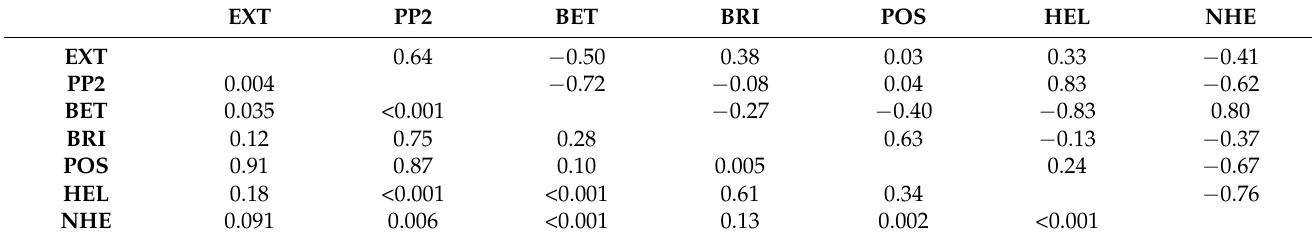
Table 2. Pair-wise comparison of the propensity scales for the ( ϕ , ψ ) clusters identified in the Ramachandran plot. The correlation coefficients R and the p -values are reported on the right and left sides of the diagonal, respectively. The ensemble of the eighteen non-Pro/non-Gly residues is